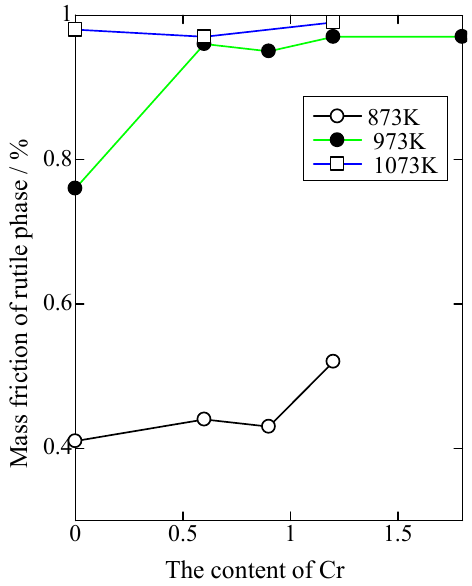
Figure 50. The change of X R with the content of Cr.